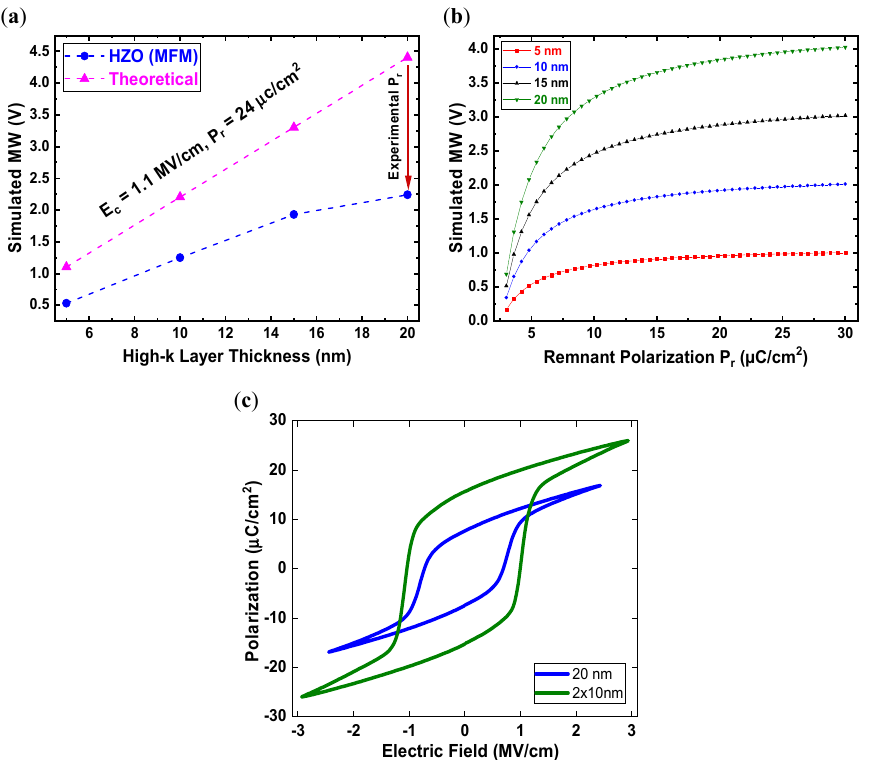
Figure 5. The simulated FeFET MW variation with ( a ) ferroelectric layer thickness based on the measured HZO P-E parameters versus the theoretical ones, ( b ) the ferroelectric P r at different ferroelectric thicknesses shows a lower MW with a P r decrease, ( c ) the benchmark of a single versus laminated MFM-based P-E hysteresis of a 20 nm HSO layer. Reproduced with permission from [17] T. Ali et al., IEDM; published by IEEE, Copyright 2019, IEEE.